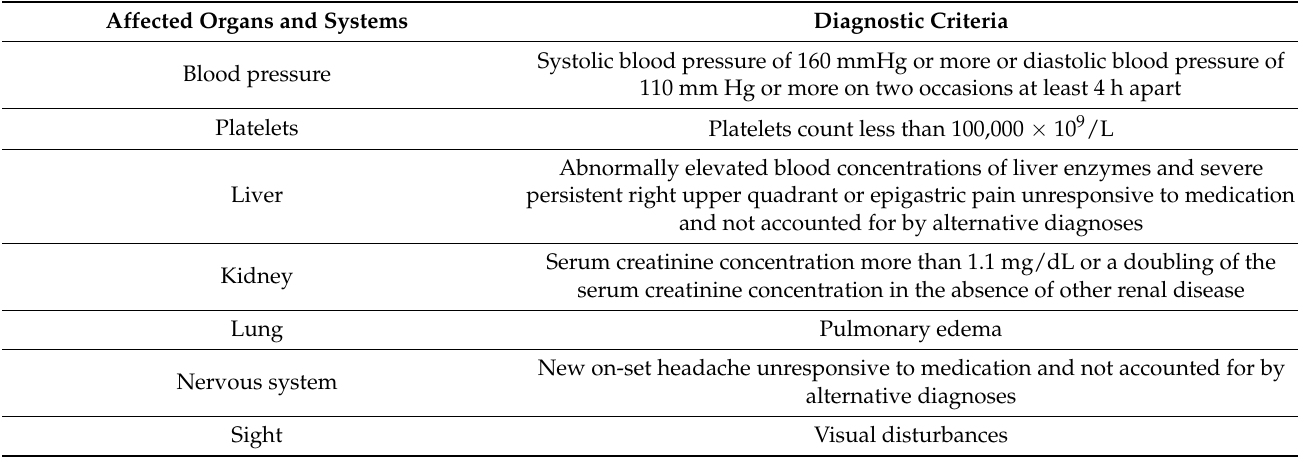
Table 2. Diagnostic criteria of severe preeclampsia